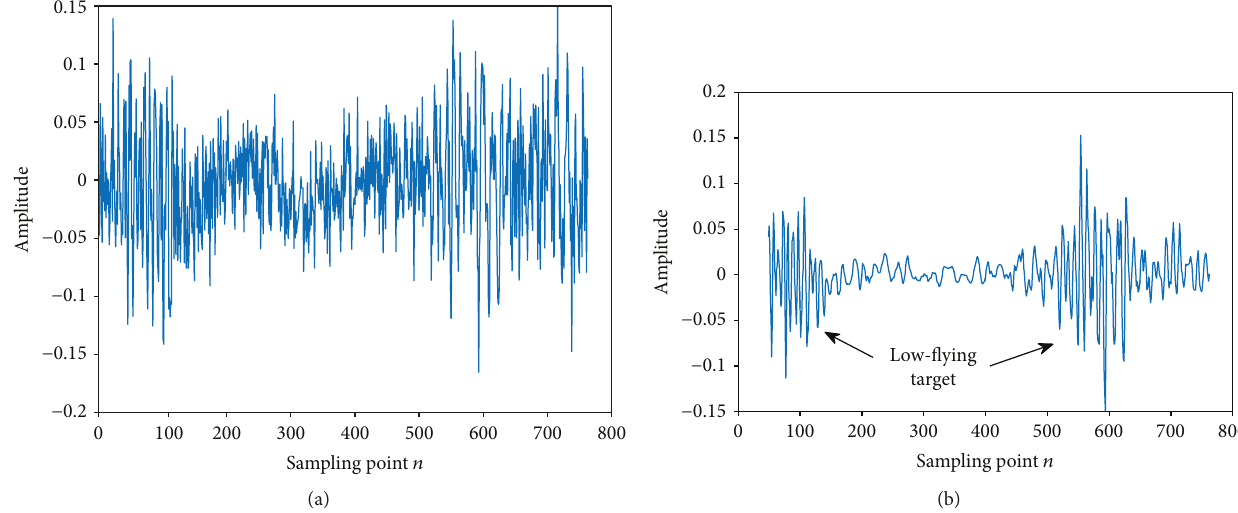
Figure 9: Comparison of prediction error of 17#9th distance gate sea clutter before and after de-noising. (a) Prediction error before de- noising. (b) Prediction error after